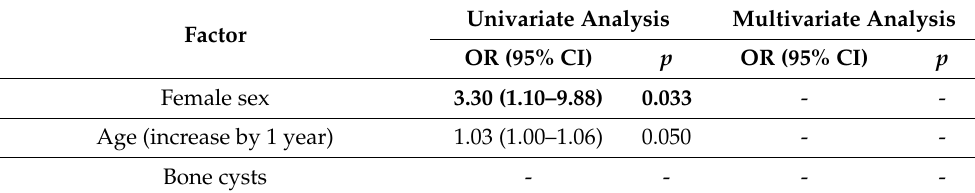
Table 13. Logistic regression for the dependent variable of seronegative RA vs. the independent variable of PsA considering the types of